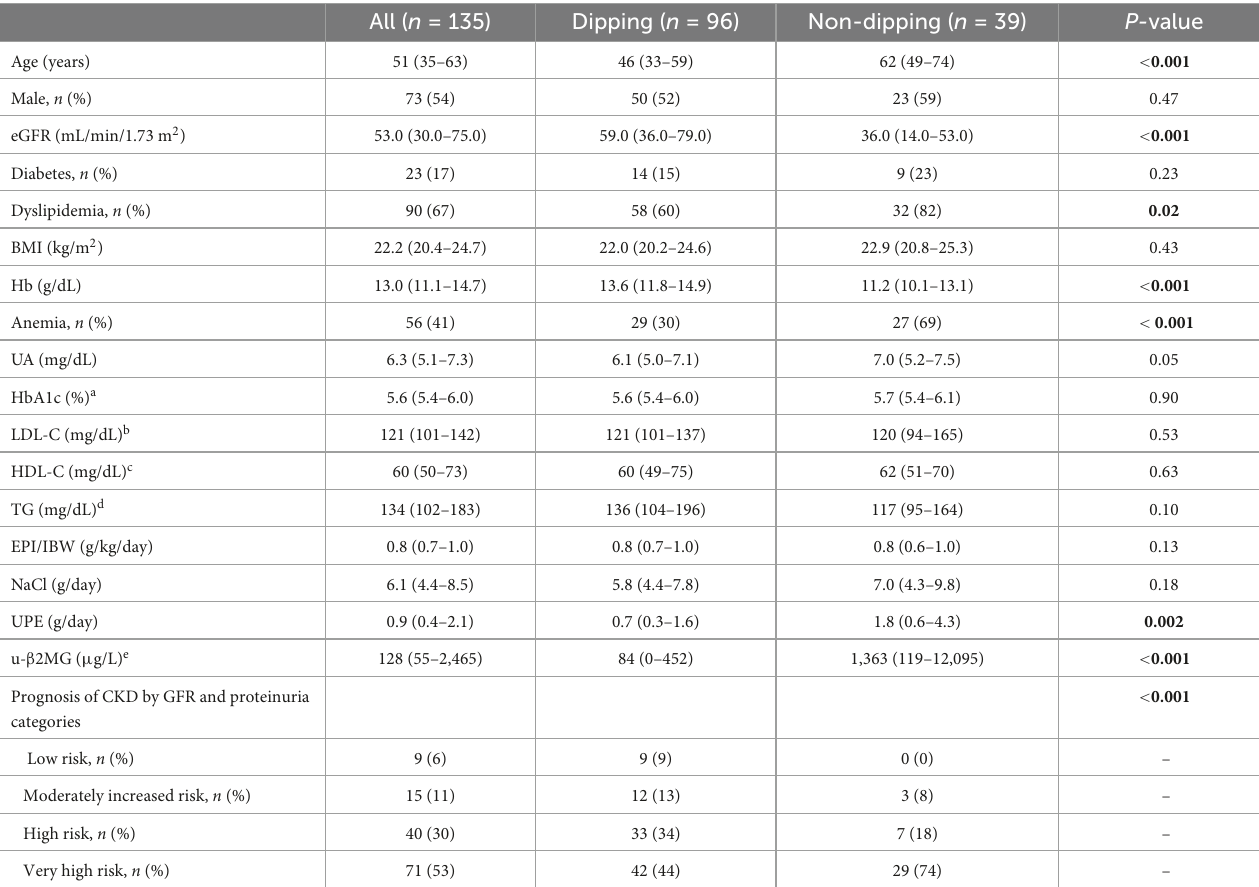
TABLE 1 Clinical and demographic characteristics of the subjects according to the dipping and non-dipping pulse rate pattern.